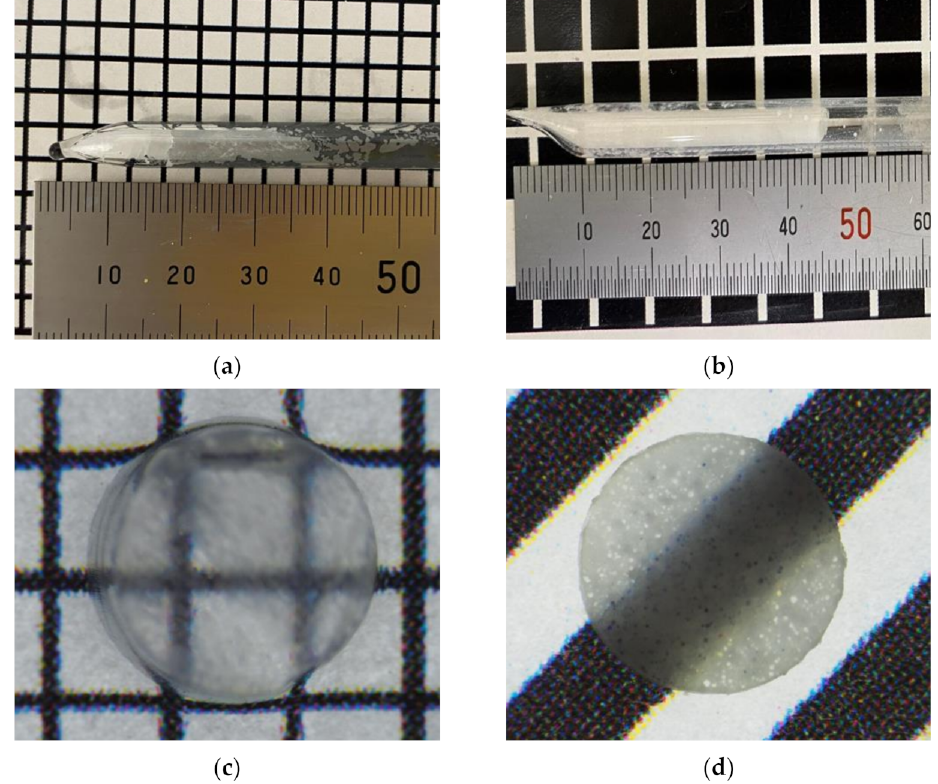
Figure 2. Photographs of growth eutectic crystals ( a ) K 2 CeCl 5 /LiCl, ( b ) CeCl 3 /SrCl 2 /LiCl, and 1 mm thick wafer of ( c ) K 2 CeCl 5 /LiCl and ( d ) CeCl 3 /SrCl 2